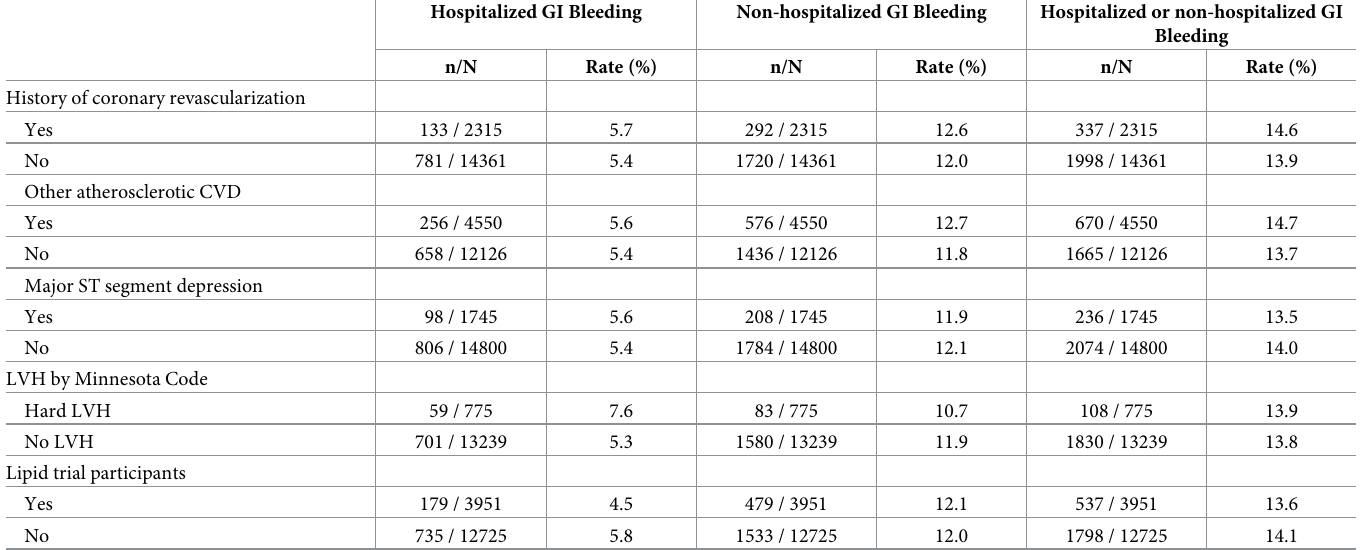
chlorthalidone arms, respectively) (Table 2) and was not statistically significantly different among the 3 groups after adjusting for confounders in multiple Cox regression models (Table 3). For example, the hazard ratios of having GI bleeding in those receiving chlorthali- done and lisinopril were 1.05 (95% CI: 0.95–1.16) and 1.01 (0.91–1.13) respectively as com- pared to those receiving amlodipine, whereas the hazard ratio of GI bleeding was 0.97 (0.88– 1.07) in those receiving lisinopril as compared to subjects receiving chlorthalidone (Table 3). Table 2 also presents the cumulative incidence of GI bleeding by age, gender, race/ethnicity, previous use of antihypertensives, use of aspirin and estrogen, HDL cholesterol level, smoking status, and history of comorbid conditions (diabetes, CHD, CVD, MI, stroke, or CABG). For example, the cumulative incidence of hospitalized GI bleeding was higher in patients aged 70 or older (6.4%) than those 55–64 (5.1%) or 65–69 (4.0%). The cumulative incidences of GI bleeding were similar by other factors in Table 2. Furthermore, Table 3 presents the results of interaction between trial drugs and those fac- tors (age, gender, race, aspirin use, and smoking status) on the risk of GI bleeding, but did not find any of these interactions significant. Table 4 classified the cumulative incidence at 3 differ- ent time intervals: at 1 year, 3 year and 5 year for overall population and also for the stratified results by age, sex, race, use of aspirin and estrogen, and smoking status. Although the cumula- tive incidence rates of GI bleeding increased substantially at 5 years as compared to those at 1 year, the cumulative incidence rates of GI bleeding were generally similar among the 3 trial arms (lisinopril, amlodipine, and chlorthalidone). However, in those with prior aspirin use and smoking group, patients with lisinopril had slightly higher incidence of GI bleeding (13.3% and 12.5% respectively) than those with amlodipine (10.2% and 9.8% respectively). Table 5 presents the adjusted hazard ratios of GI bleeding for comparisons among 3 differ- ent trial arms as well as comparison among other factors. For example, as compared to those receiving chlorthalidone, patients who received amlodipine did not have a significantly differ- ent risk of developing GI bleeding [HR = 1.03, 95% CI: 0.87–1.22 from inpatient data, or 1.01 (0.90–1.14) from outpatient data]. The increased risk of GI bleeding by age was statistically sig- nificant after adjusting for confounders in the Cox regression models (HR = 1.04 per